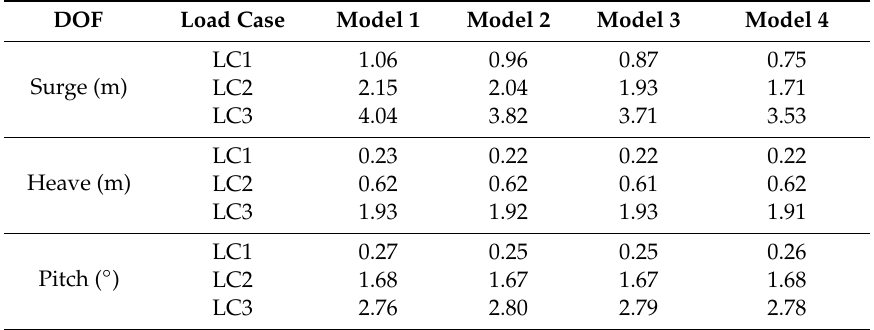
Table 10. Amplitudes of the stationary motion of the multi-segmented mooring line models. Load Case Model